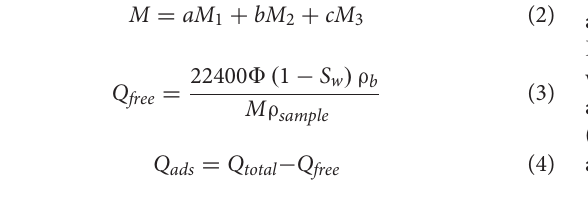
Mineral composition